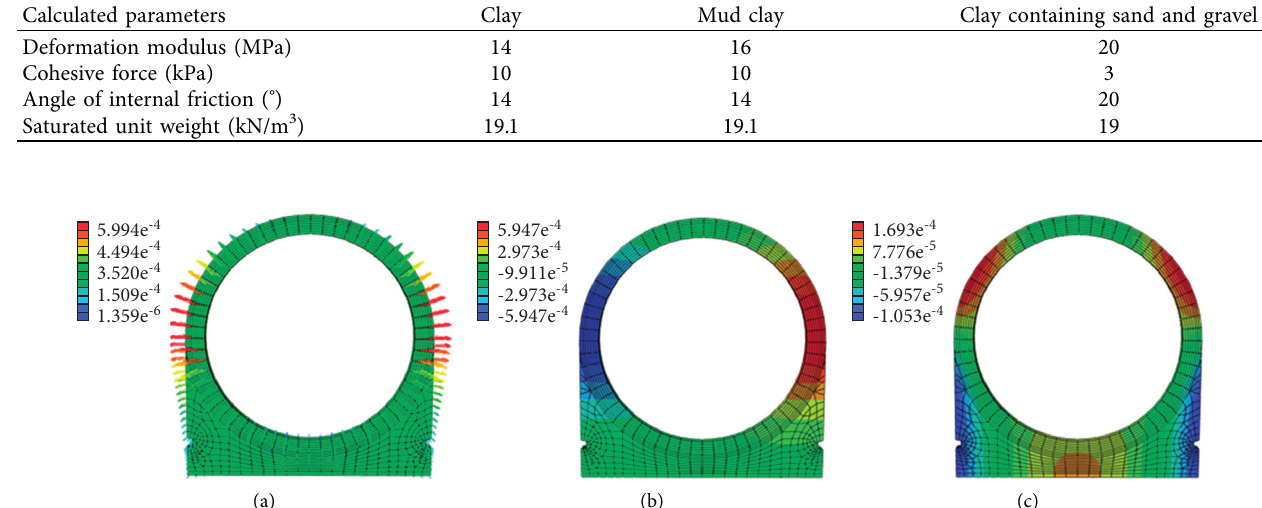
Figure 12: Incremental deformation of the prestressed culvert structure: (a) deformation vector diagram; (b) horizontal deformation; (c) vertical deformation.